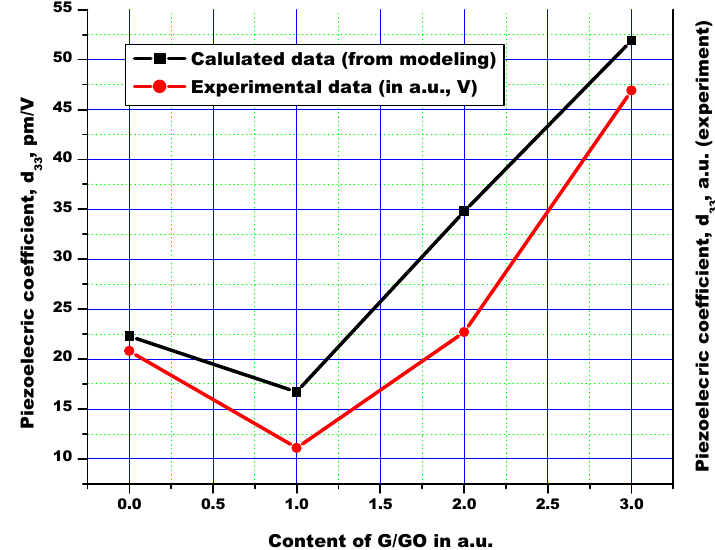
Figure 13. Trend of changes for computed d 33 using curved models of PVDF + Graphene as compared to the experimental data.